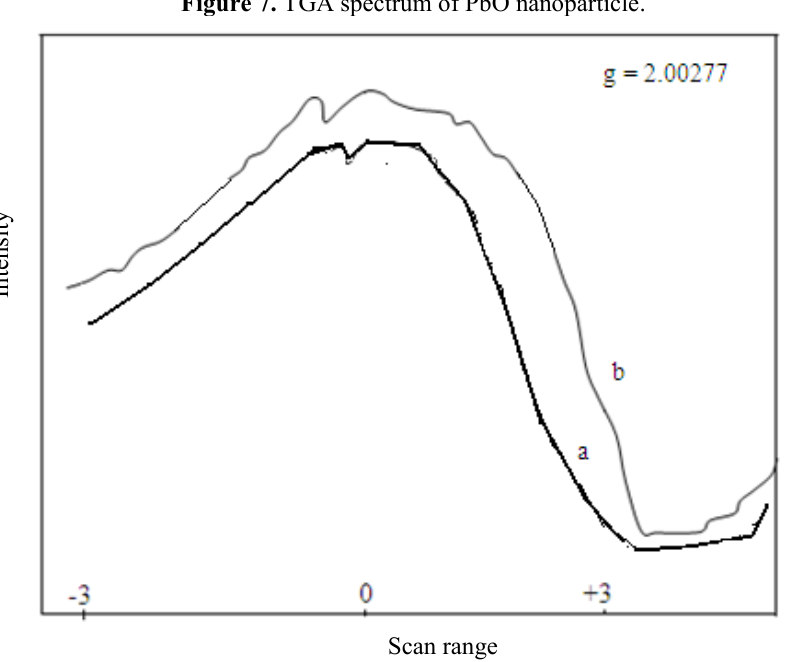
Figure 7. TGA spectrum of PbO nanoparticle.